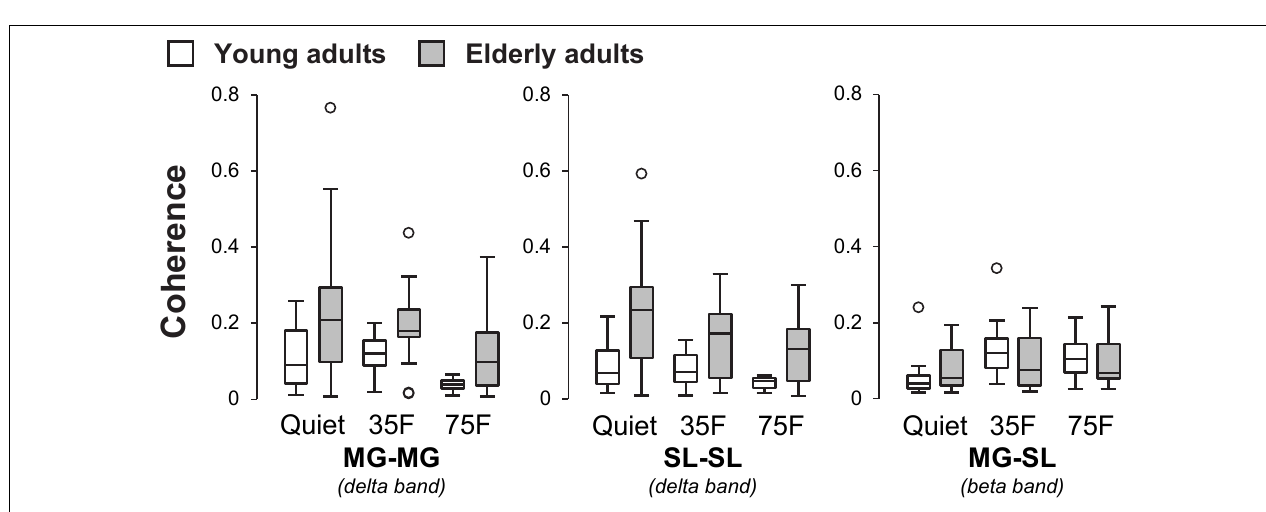
FIGURE 5 | Effects of task and age on z-transformed coherence. Tasks were quiet standing (Quiet), 35% forward lean (35F), and 75% forward lean (75F). Data are presented separately for each muscle pair. Small circles indicate outliners. MG, medial gastrocnemius; and SL,